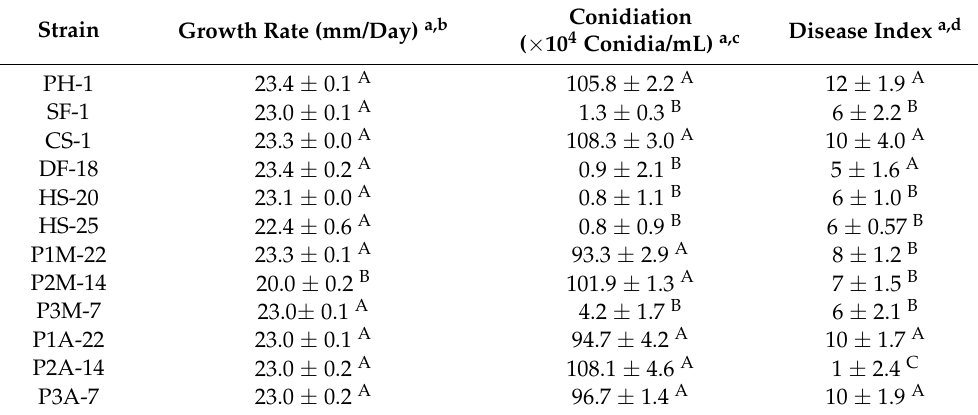
Table 3. Phenotypes of the Fgsfl1 mutant in growth, conidiation, and plant infection. Strain